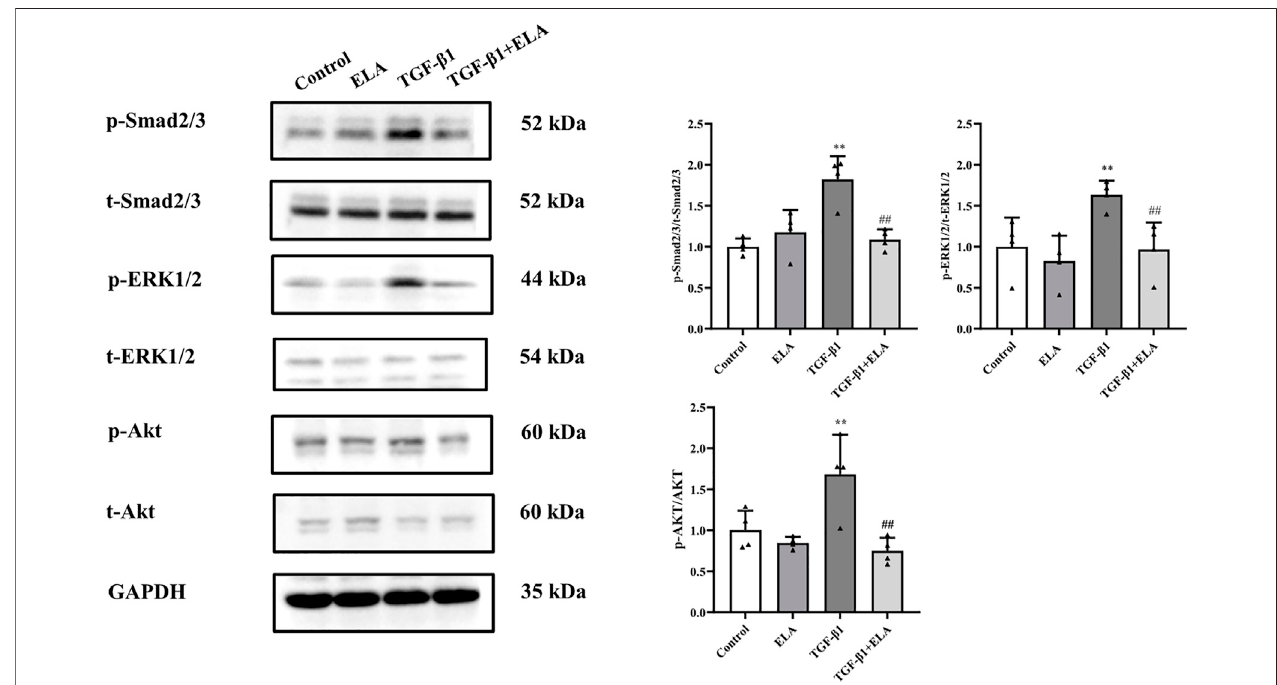
FIGURE4| EffectsofELAonTGF- β 1-inducedactivationoftheSMAD/ERK/AKTPathway.HMrSv5wasdividedintofourgroupsaccordingtodifferenttreatments: 1) Control group where cells were cultured with DMEM medium containing 10% FBS after 24 h of synchronization; 2) ELA group where cells were treated with ELA-32 (10 μ M)for24 h;3)TGF- β 1groupwherecellsweretreatedwithTGF- β 1(10 ng/ml)for24 h;andTGF- β 1+ELAgroupwherecellswereco-treatedwithTGF- β 1(10 ng/ml) and ELA-32 (10 μ M) for 24 h. After stimulate for 24 h, the expression of p-SMAD2/3, p-ERK1/2, and p-AKT were detected by Western blotting. Four independent experiments were carried out in each group. Data are expressed as mean ± SD, ** p < 0.05 vs. control group; ## p < 0.05 vs. TGF- β 1 group. Abbreviations: ELA, elabela; TGF- β 1, transforming growth factor- β